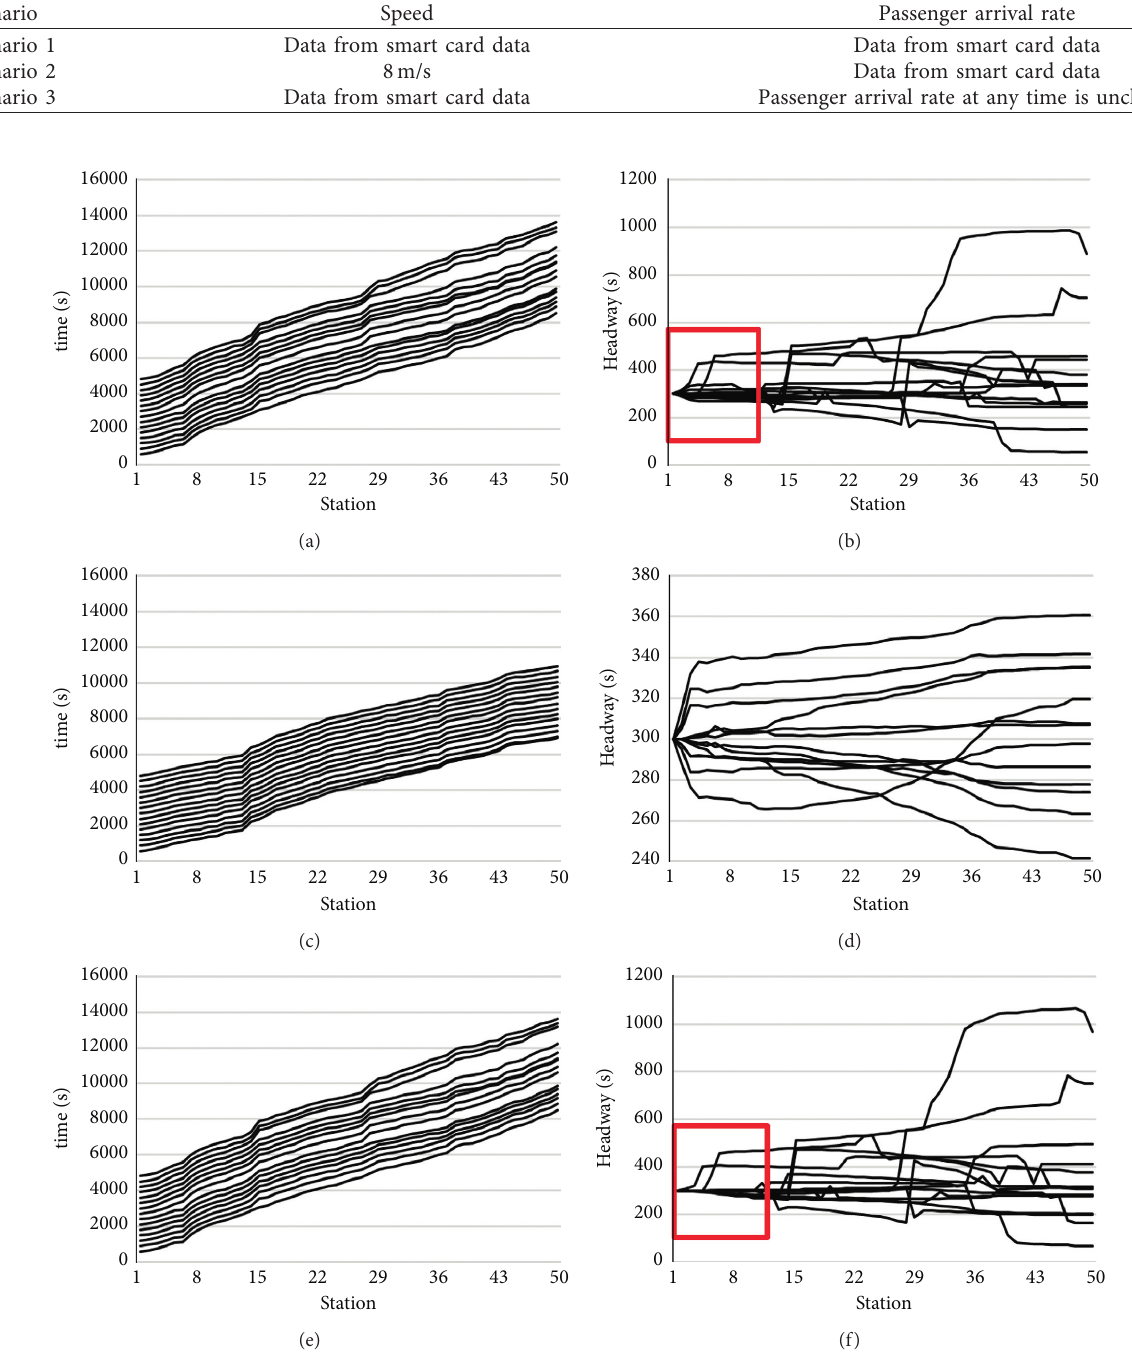
Figure 4: Simulation results in three scenarios: (a) bus trajectories for scenario 1 and (b) headway for scenario 1; (c) bus trajectories for scenario 2 and (d) headway for scenario 2; (e) bus trajectories for scenario 3 and (f) headway for scenario